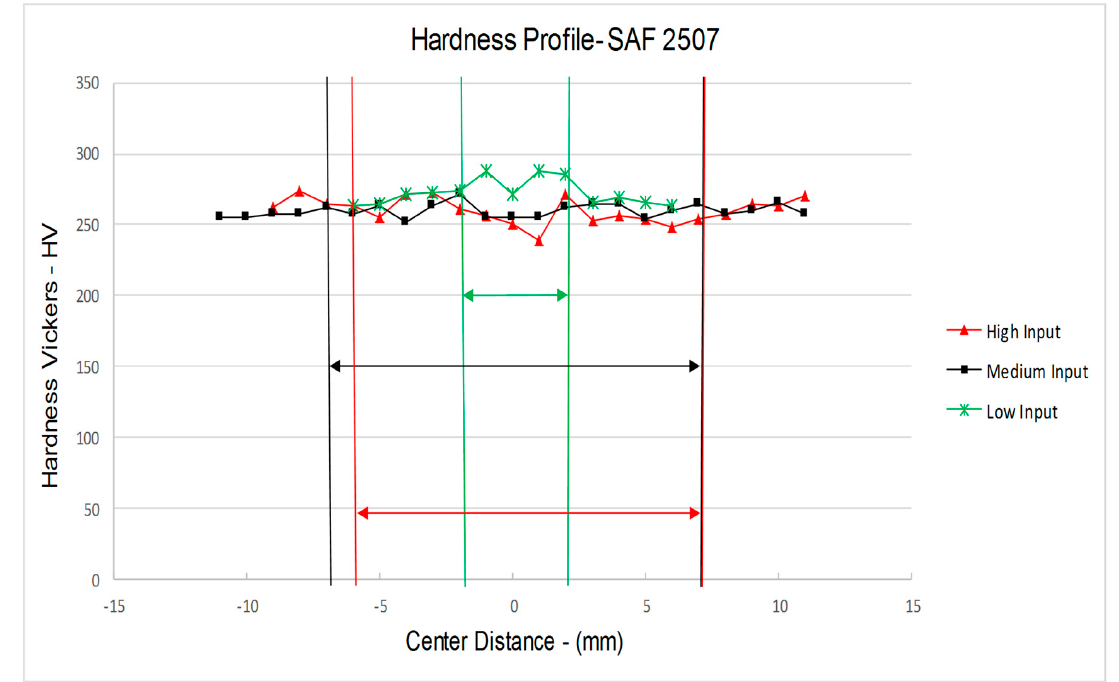
Figure 14. Vickers Hardness-SAF 2507. The arrows represent the distance from the weld center. i.e., width of WM. Values were measured from the base metal to the base metal, i.e., BM, LT-HAZ, HT-HAZ, WM, HT-HAZ, LT-HAZ, BM.